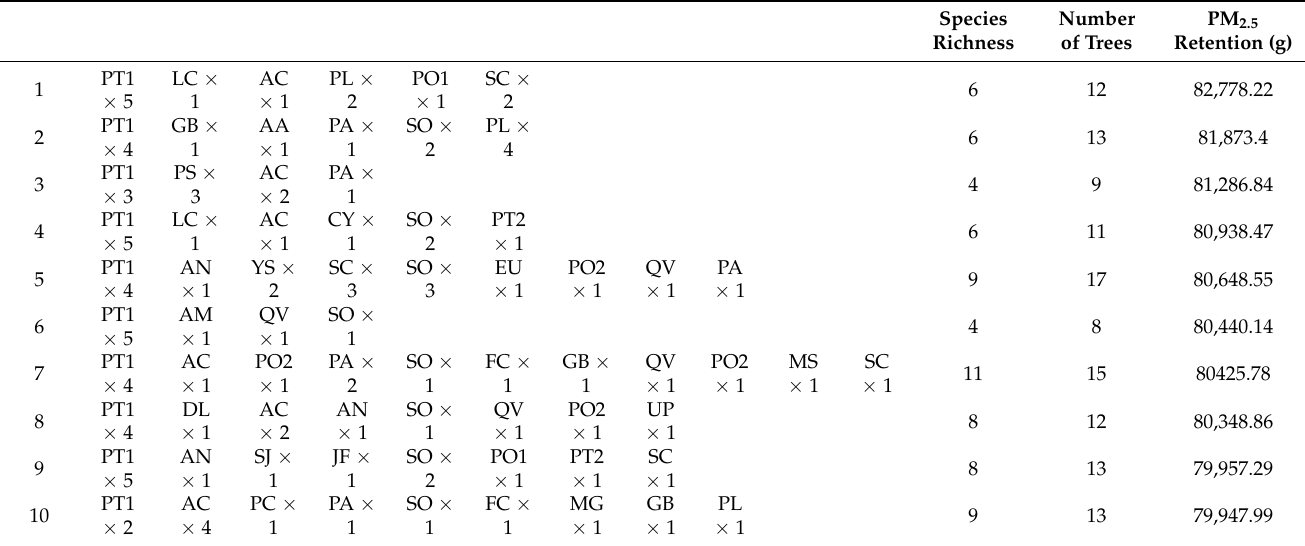
Table 4. Optimization of the green space structure using 48 broad-leaved and 8 coniferous tree species.